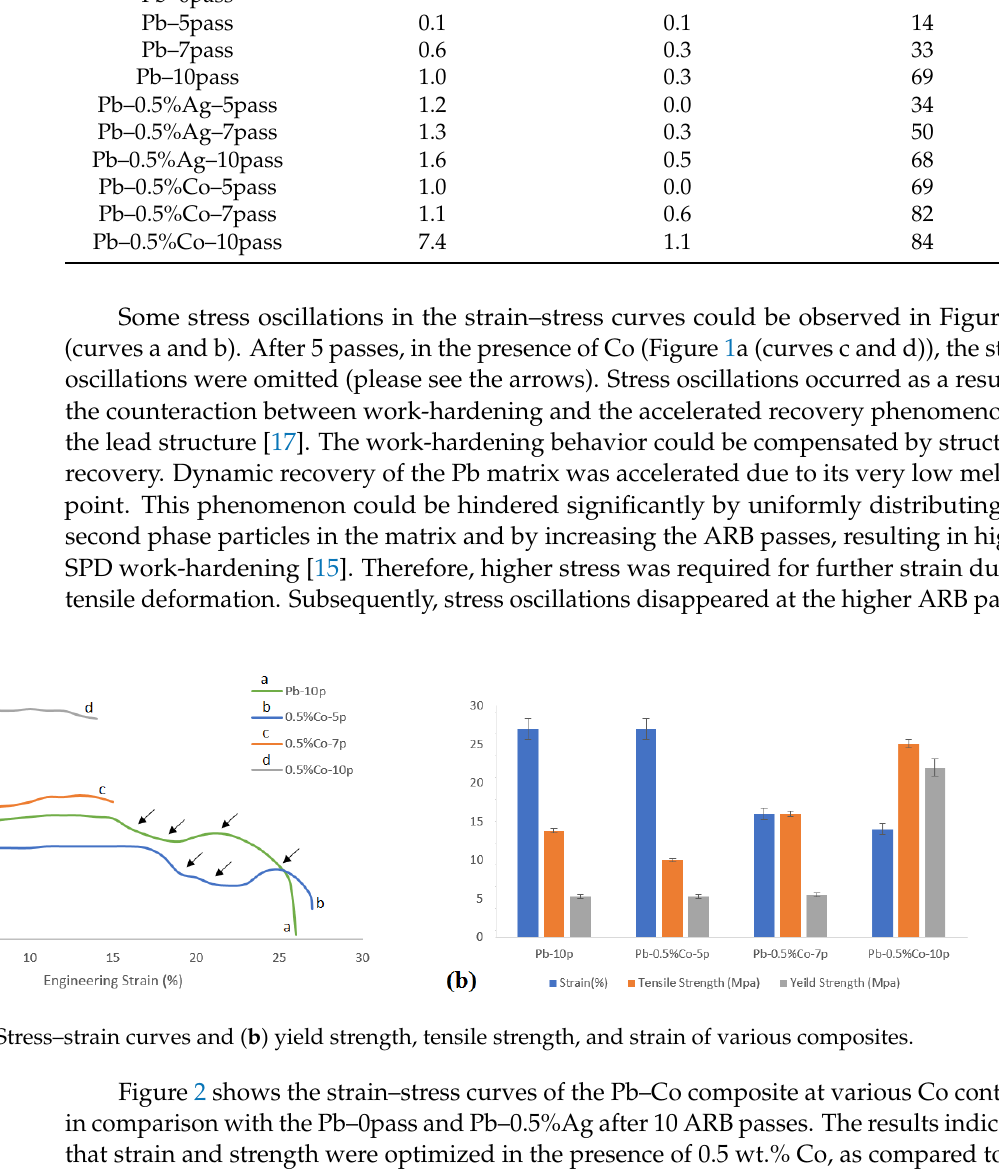
Table 3. Yield strength, tensile strength, and strain of various samples. Increase Yield